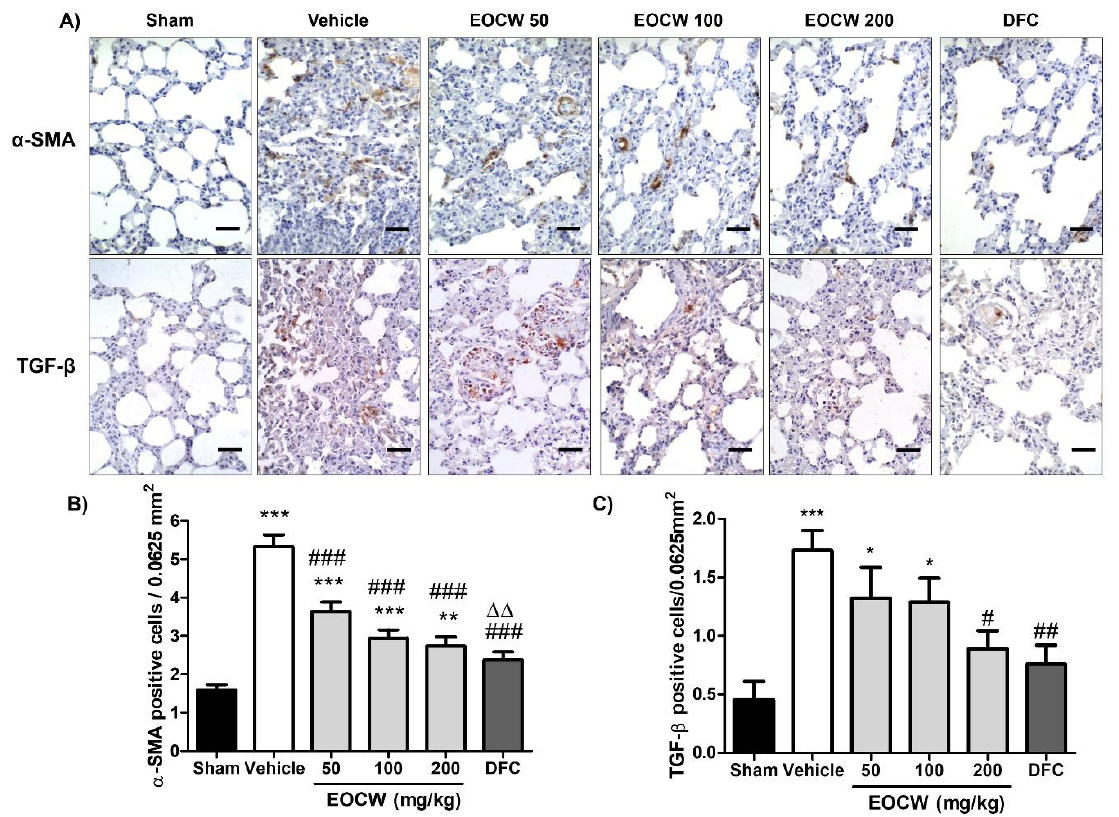
Figure 4. ( A ) Cytoplasmic positivity pattern of immunohistochemical expression of α -SMA and TGF- β in group Sham and subjected to bleomycin-induced pulmonary fibrosis (Masson’s trichrome, 400 × ). ( B ) Assessment of the immunohistochemical expression of α -SMA and ( C ) TGF- β in the pulmonary tissue of the experimental groups. Significant differences compared to group Sham are expressed as * p < 0.05, ** p < 0.01 and *** p < 0.001; compared to group Vehicle are expressed as # p < 0.05, ## p < 0.01 and ### p < 0.001; compared to EOCW50 are expressed as ∆∆ p < 0.01 (ANOVA and Tukey’s multiple comparisons test).